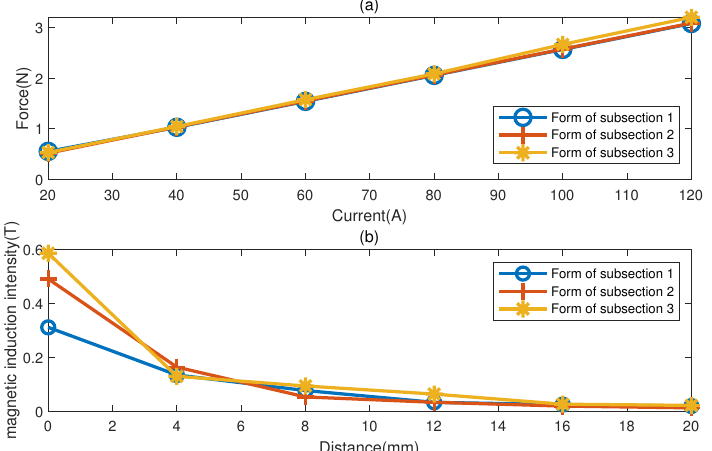
Figure 8. ( a ) Influence of magnetic rod in suspension model on relation curve of current and electromagnetic force. ( b ) The influence of magnetic rod on the relation curve between distance and magnetic induction intensity. The distance refers to the distance from the point to the end of the magnetic rod, and the point is on the axial line of the magnetic rod.